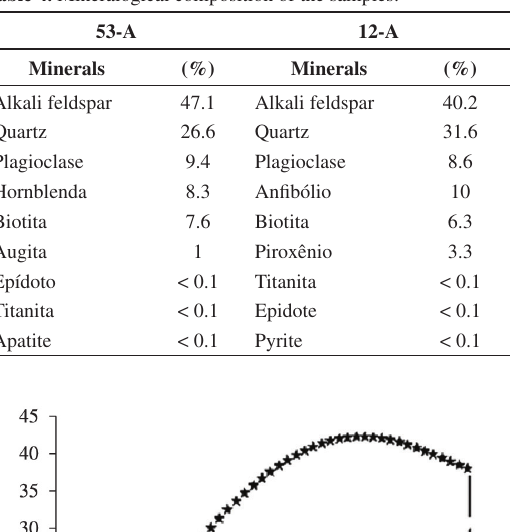
Table 4. Mineralogical composition of the samples.